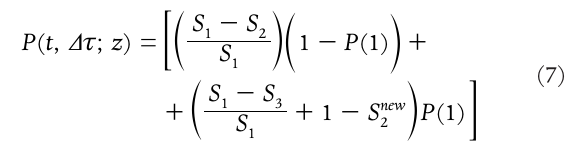
Figure 6. The magnitude versus frequency relationship of the M since 1981 (data from the CSI catalog). The value of b of the GR relationship is plotted from a maximum likelihood